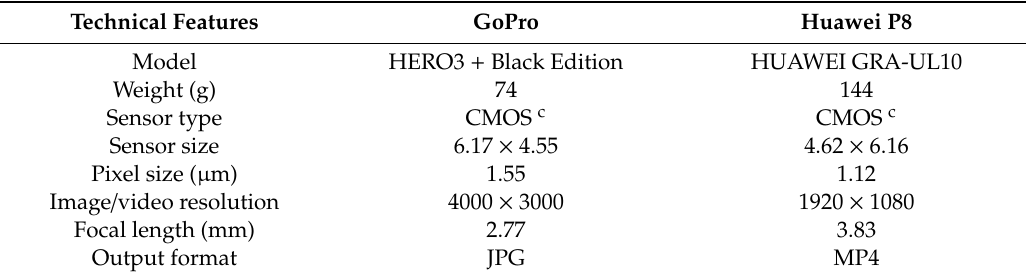
Table 2. Technical features of each one of the cameras used in this study.